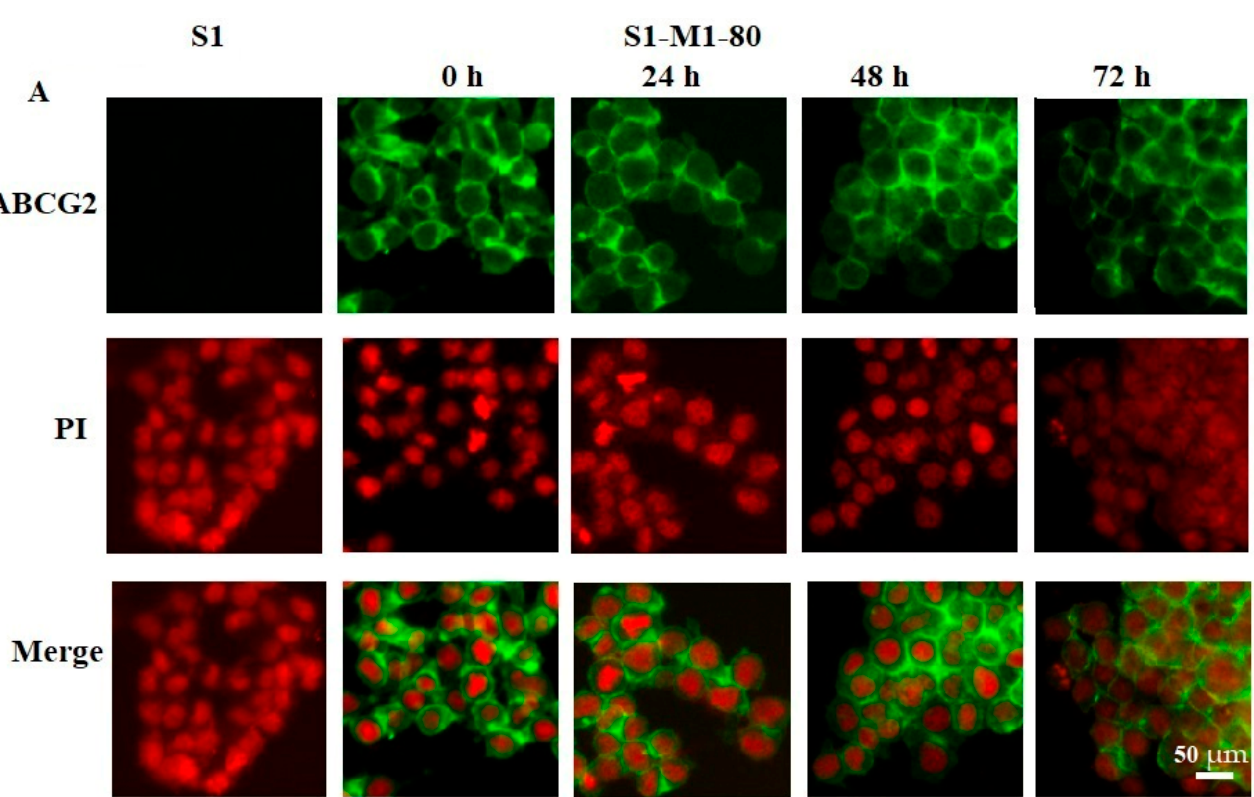
Figure 4. The effect of VKNG-1 on the expression and localization of ABCG2. S1 and S1-M1-80 cells were incubated with 6 µM of VKNG-1 for 24, 48, 72 h, respectively. The green color represents the ABCG2 transporter, and the red color represents the nucleus. The scale bar is 50 µm.